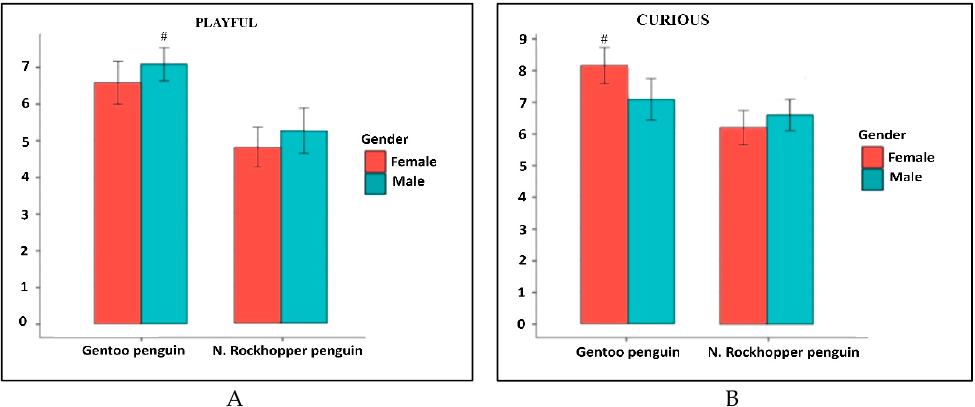
Figure 3. Graphic representation of the traits that showed di ff erences between males and females. with values very close to statistical significance, which was present in the di ff erence between the species. In ( A ) Playful; in ( B ) Curious. p < 0.05 values are considered as statistically di ff erent. # = Gentoo vs. northern rockhopper.